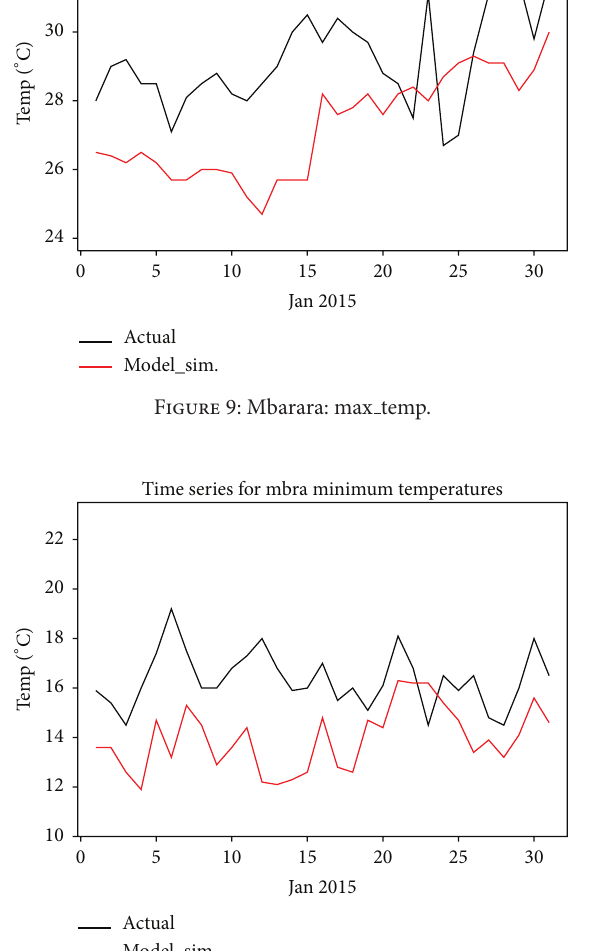
Figure 10: Mbarara: min temp.